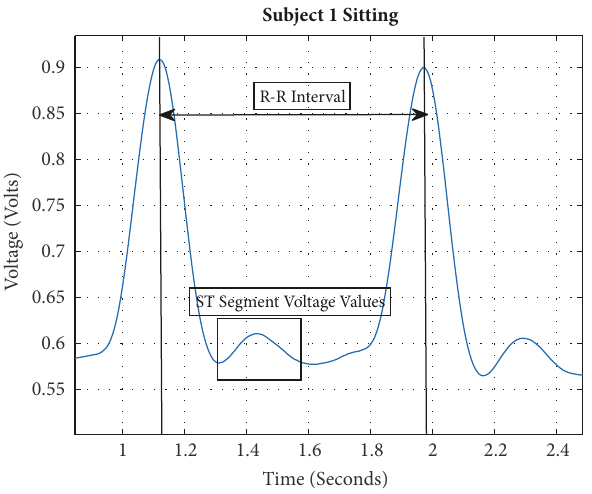
Figure 12: Sample ECG with R-R interval and ST